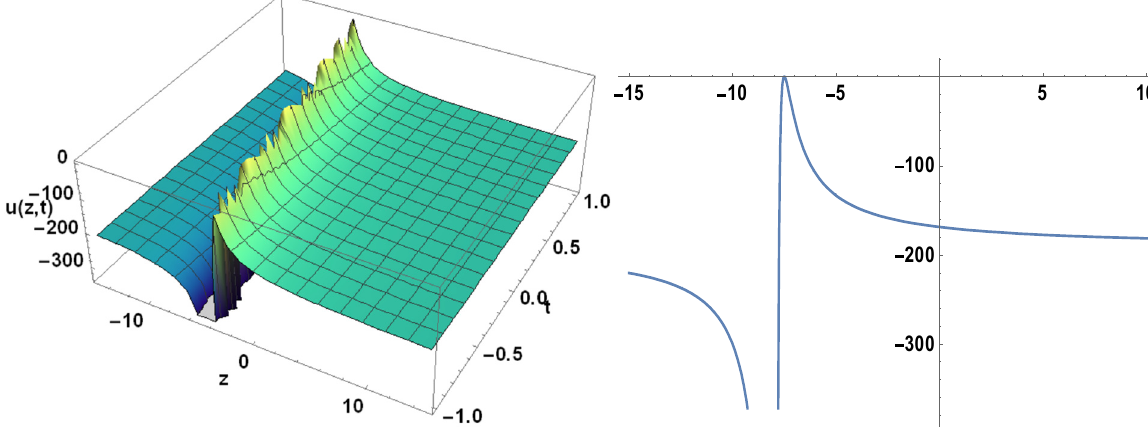
Figure 9. The 3D and 2D plots of Equation (59) for various values of parameters.